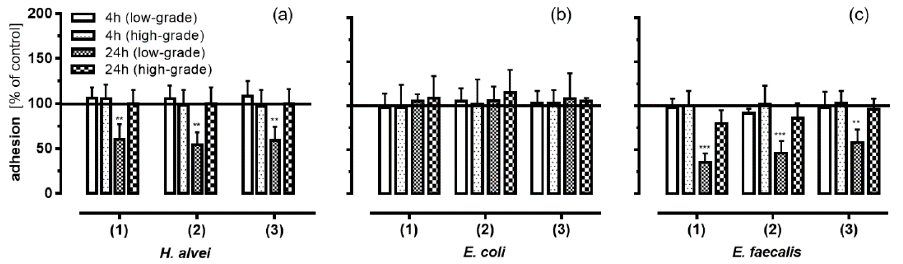
Figure 3. Anti-adhesive effect of ACNs after MO-fermentation on leucocyte adhesion to HUVECs under inflammatory conditions by ( a ) H. alvei ; ( b ) E. coli and ( c ) E. faecalis . After incubation of Caco-2 cells with fermented ACNs from the lag- (1), log- (2) and stat-phase (3), transwell inserts were removed, and the co-cultured HUVECs were used immediately (4 h) or were further incubated in the basolateral compartment (20 h). Thereafter, cells were stimulated for 3 h using 1 ng/mL TNF- α (low-grade inflammation) or 10 ng/mL TNF- α (high-grade inflammation). After TNF- α stimulation, leukocyte adhesion was measured as described in the Materials and Methods section. Corresponding controls (maximal adhesion to HUVECs after low-grade or high-grade TNF- α stimulation) were set to 100%. Values are given as the mean ± SD ( n = 3). Differences were significant at ** p < 0.01 and *** p < 0.001).